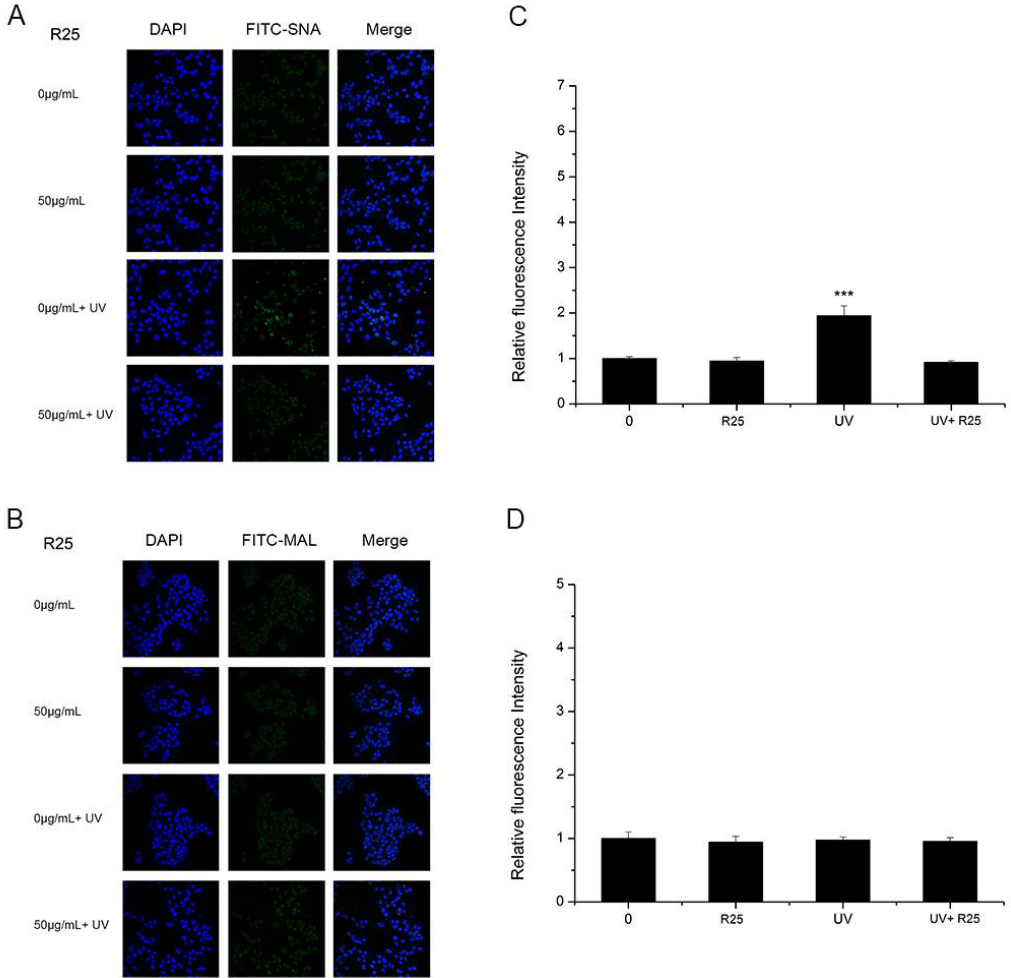
Figure 5. HaCaT cells were treated with 50 μg/mL nano-TiO 2 R25, UV or the combination of nano-TiO 2 R25 and UV. Staining was performed with FITC-labeled ( A ) Sambucus nigra agglutinin (SNA) for α-2,6 sialic acid residues (green), ( B ) MAL-I for α-2,3 sialic acid residues (green), and DAPI for nuclei (blue). The bar graphs show the fluorescent intensity analysis for ( C ) A and ( D ) B (*** p < 0.001, error bars are standard error of the mean).